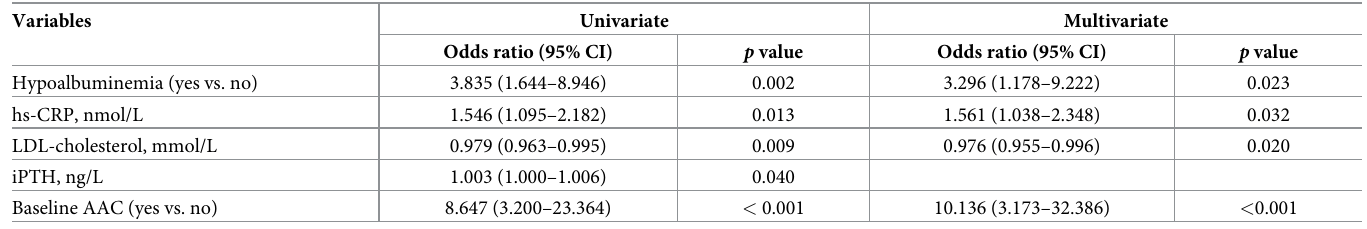
Table 4. Risk factors for abdominal aortic calcification progression.